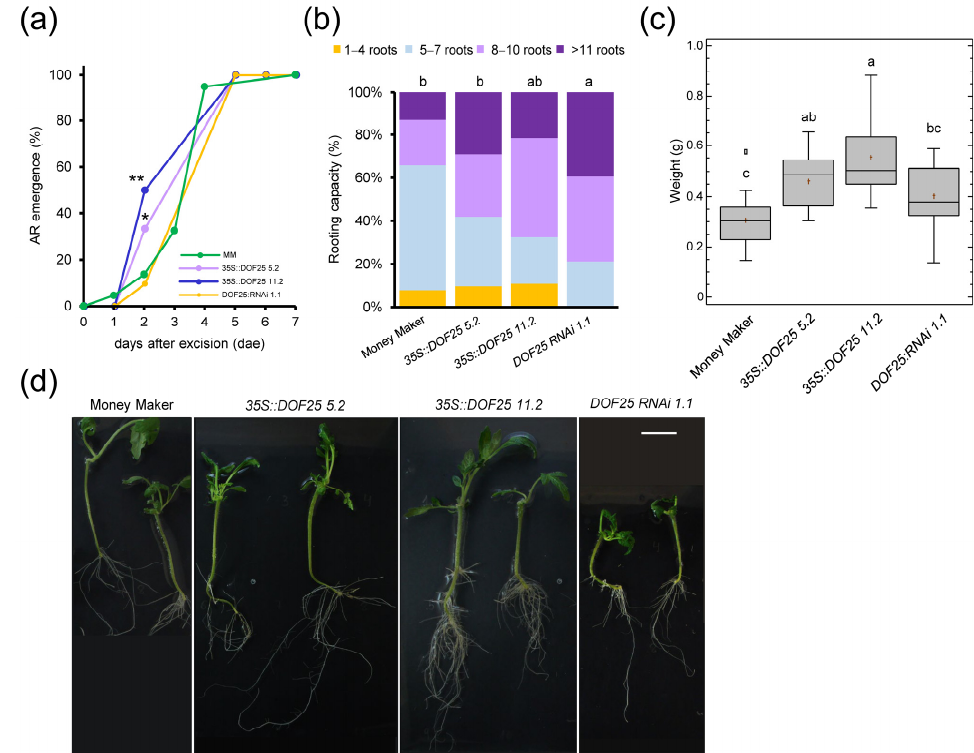
Figure 8. Wound-induced AR formation and shoot regeneration after apical cutting in CDF3 tomato mutants. ( a ) AR emergence of CDF3 overexpression lines (blue and purple), CDF3 RNAi lines (orange) and Moneymaker (MM; green). ( b ) Rooting capacity of shoot explants at 5 dae. ( c ) Weight of the apical region of the hypocotyl after 31 dae. ( d ) Representative images of regenerated explants at 31 dae. Letters in ( b , c ) indicate significant differences ( p value < 0.01) between genotypes. Asterisks in a indicate significant differences (Fisher’s LSD; p value < 0.05) between genotypes. Scale bars: 25 mm.